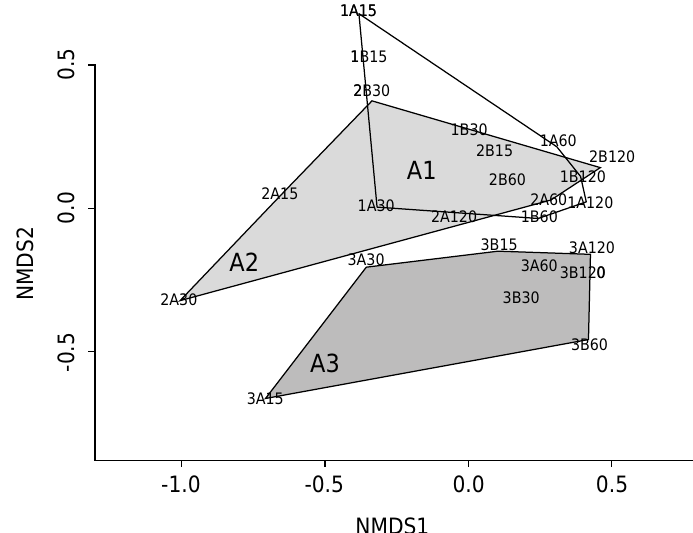
Figure 3. Non-metric multidimensional scaling analysis (NMDS) ordination in two dimensions of the sample units showing the collection structure of edaphic meso- and macrofauna in response to sampling location. First numbers correspond to areas 1, 2, and 3; the letters A and B represent the plant species tested (A = Schinus terebinthifoliu s, B = Senna multijuga ); and the numbers 15, 30, 60, and 120 are number of days of litter bag